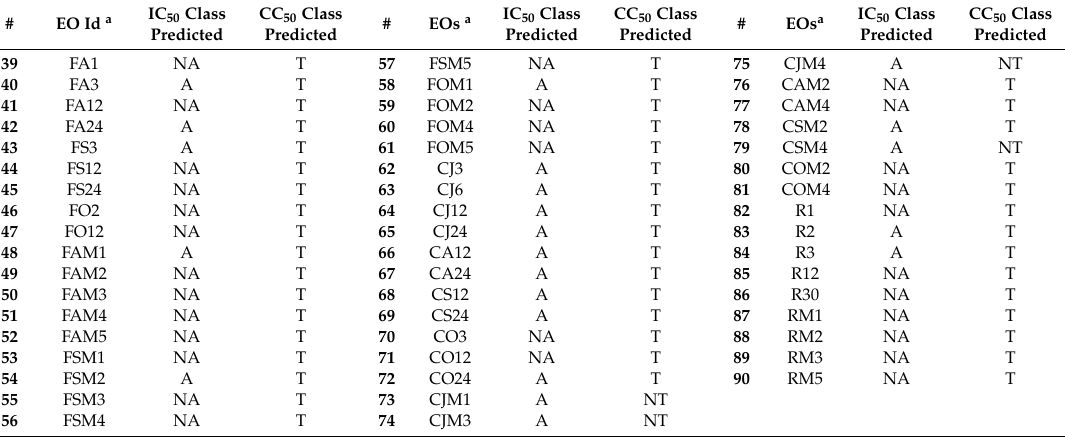
Table 4. Biological activity classes (IC 50 and CC 50 ) of the EOs used as an external test set.